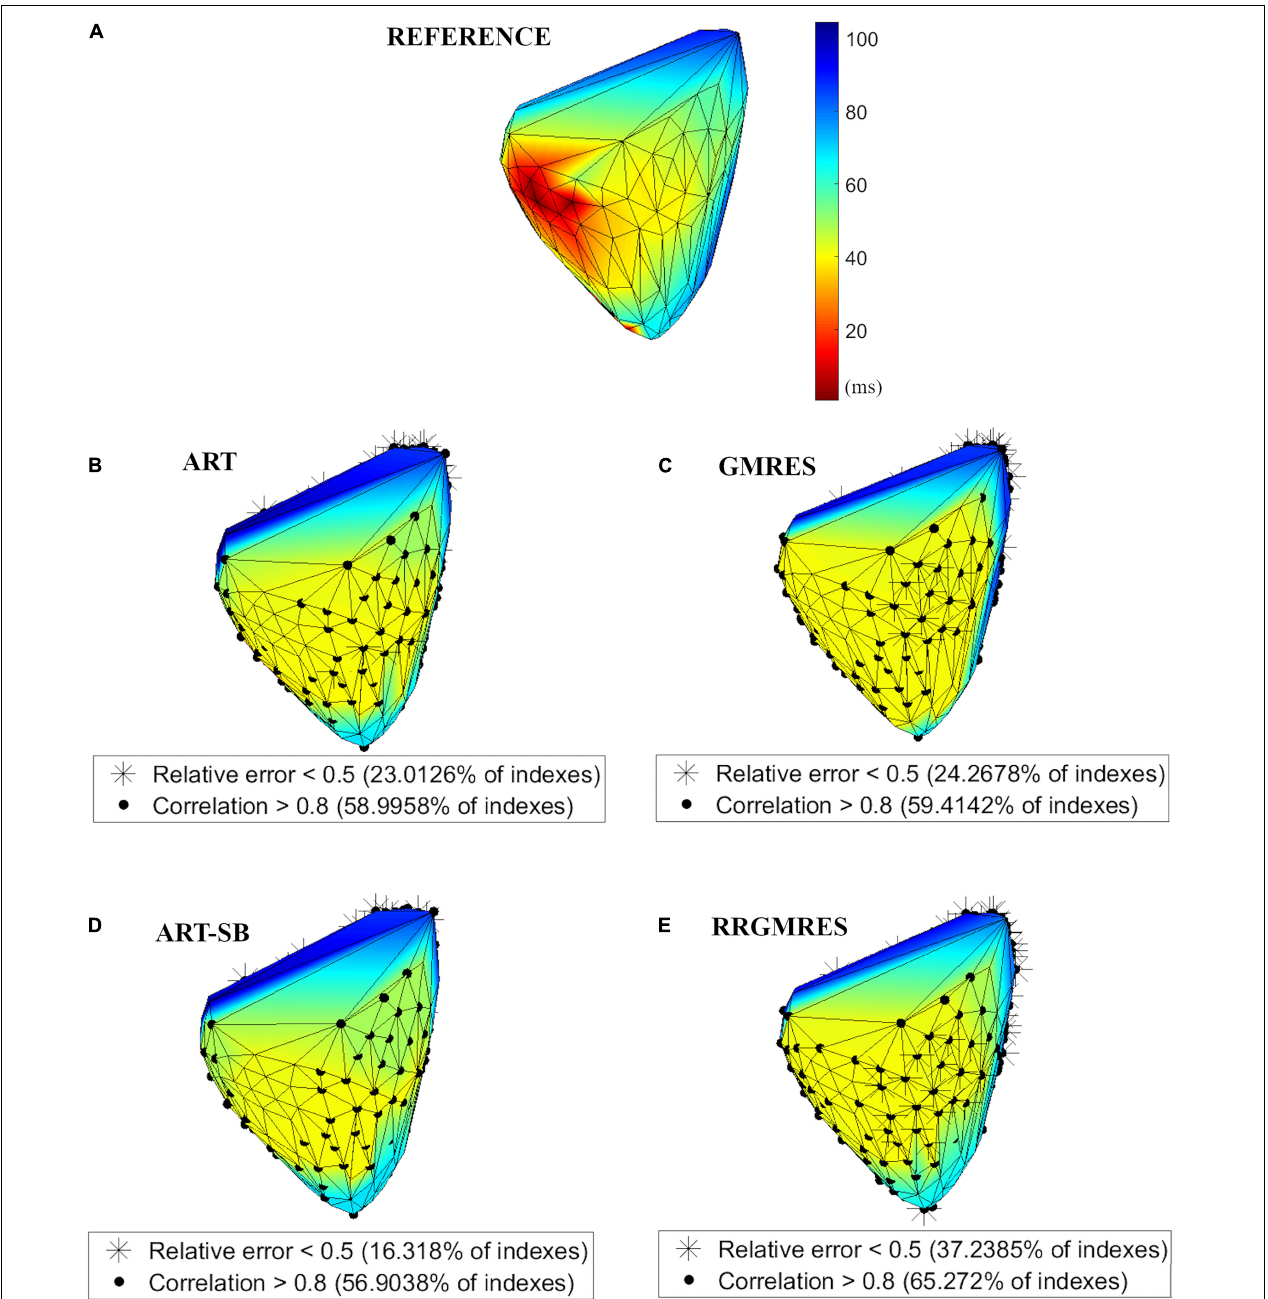
FIGURE 8 | Activation maps applied to the paced rhythm Auckland dataset, for: (A) Reference potentials; (B) ART; (C) GMRES; (D) ART Split Bregman; (E) RRGMRES. All figures have the same colorbar than panel (A) . For each activation map, the locations corresponding to the “spatial” RE < 0.5 and CC > 0.8 are overplotted as shown in the